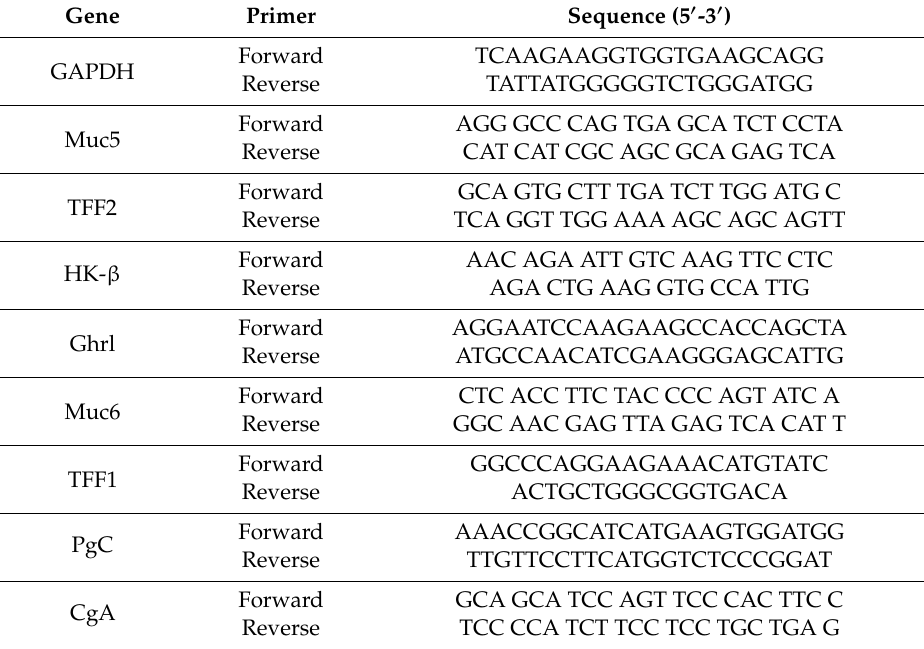
Table 1. List of primers used to quantify the expression of eight gastric cell lineage markers in VSL-treated versus control